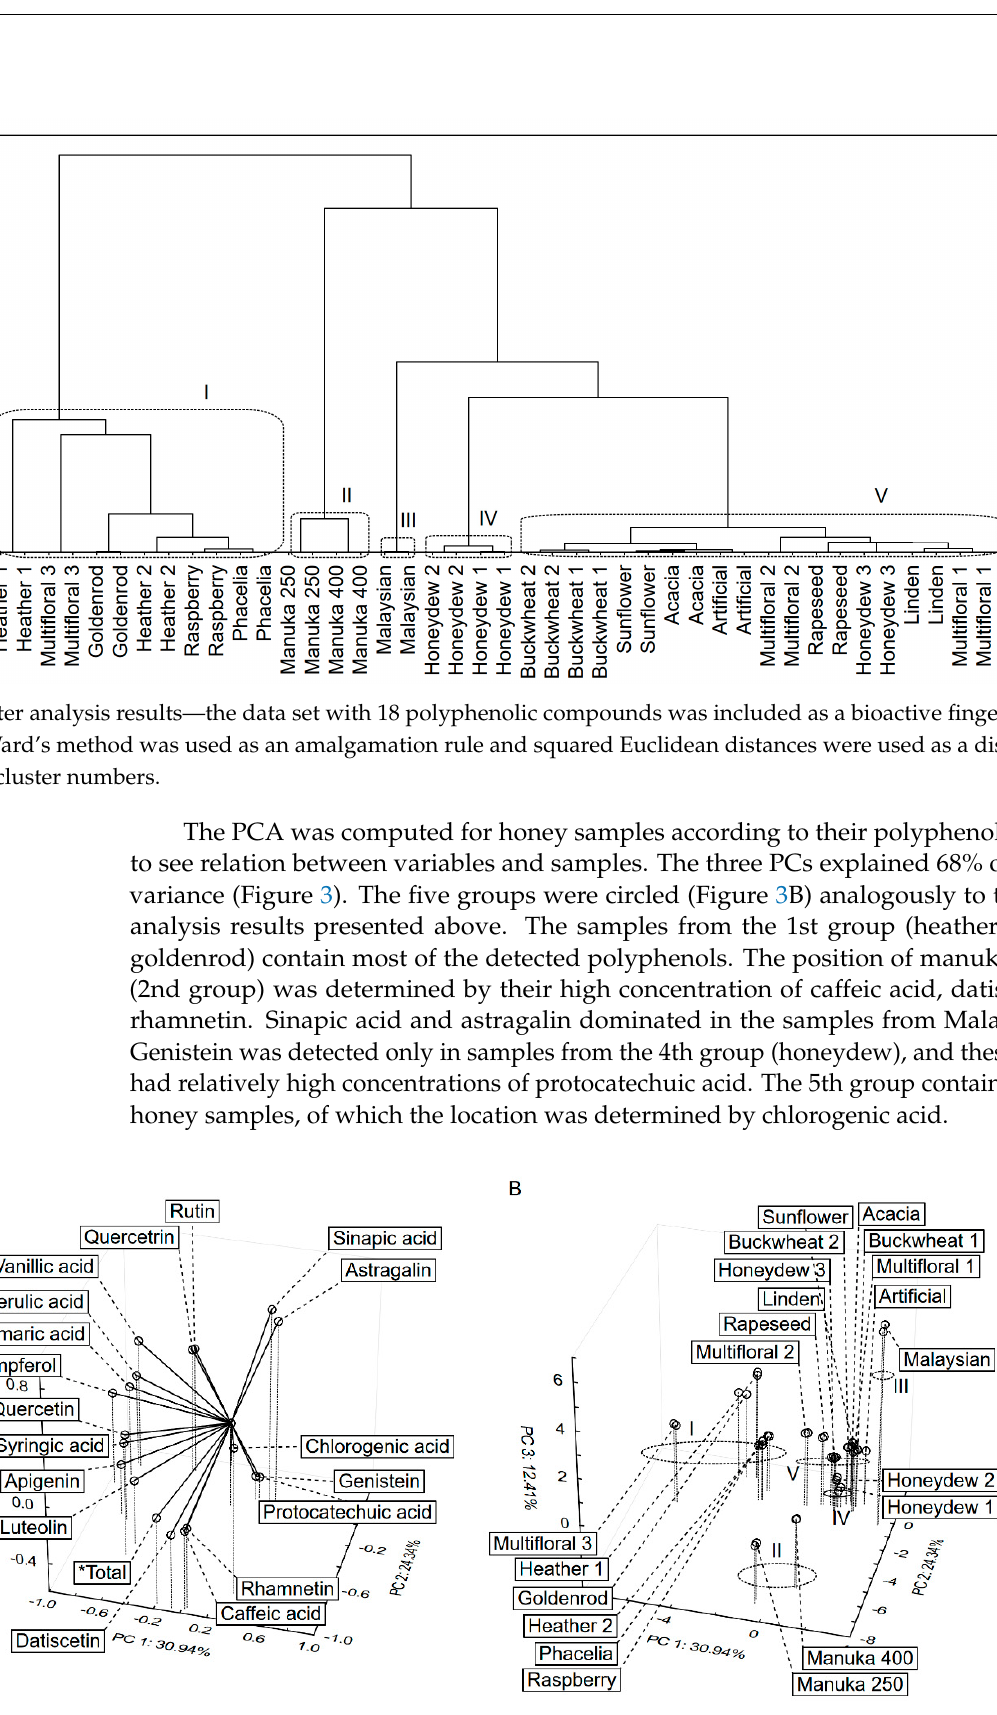
Figure 3. Principal component analysis (PCA) of phenolic profiles of honey samples, loading ( A ) and score plot ( B ).